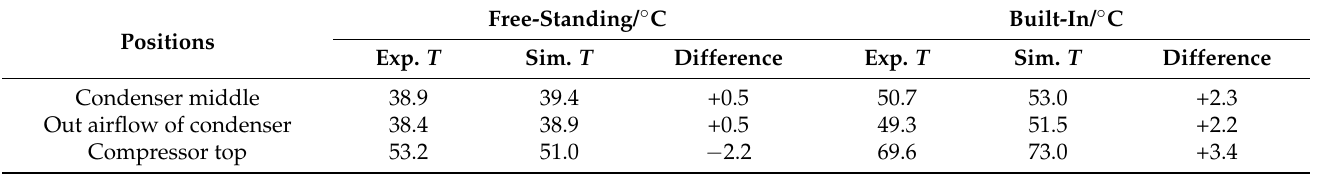
Table 3. The comparison of experimental and simulated temperatures.